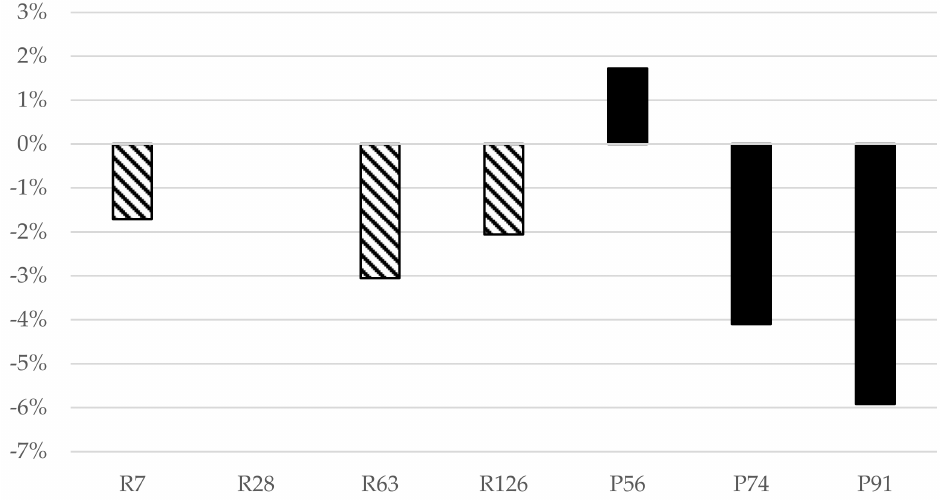
Figure 5. Percentage differences in the estimated time of corrosion